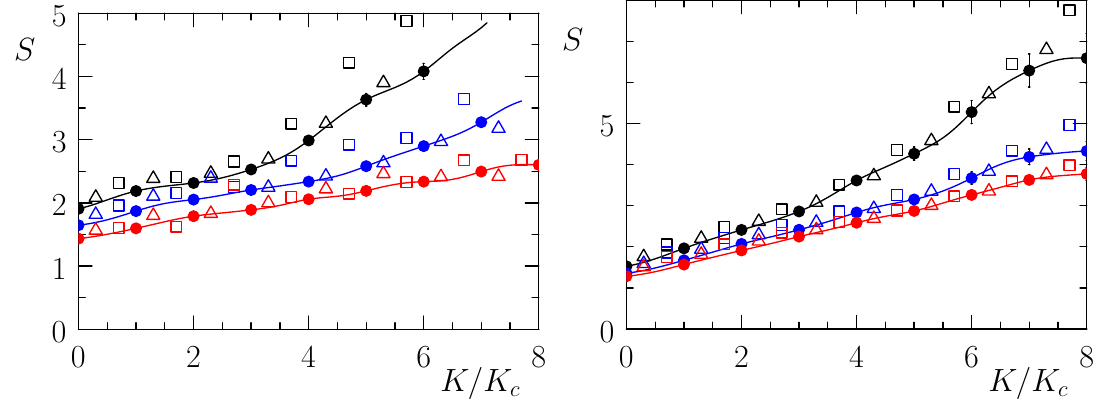
Figure A3. Dependence of the Seebeck coefficient S on the rescaled potential amplitude K / K c at different rescaled temperatures T / K c . Left panel: T / K c = 1 (black curve/symbols), 2 (blue curve/symbols), 4 (red curve/symbols); here ν = N / L = 34/21 89/55 (squares) with colors from bottom to top; K c = 0.019. Right panel: same as in the left panel for T / K c = 0.8,1.3,1.6 at same color order for ν = N / L = 55/21,89/34,144/55 order; K c =